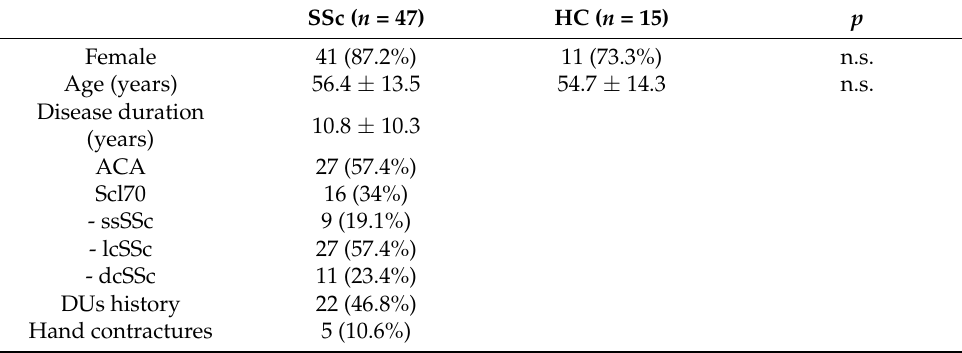
Table 1. Baseline characteristics of SSc cohort and HC.